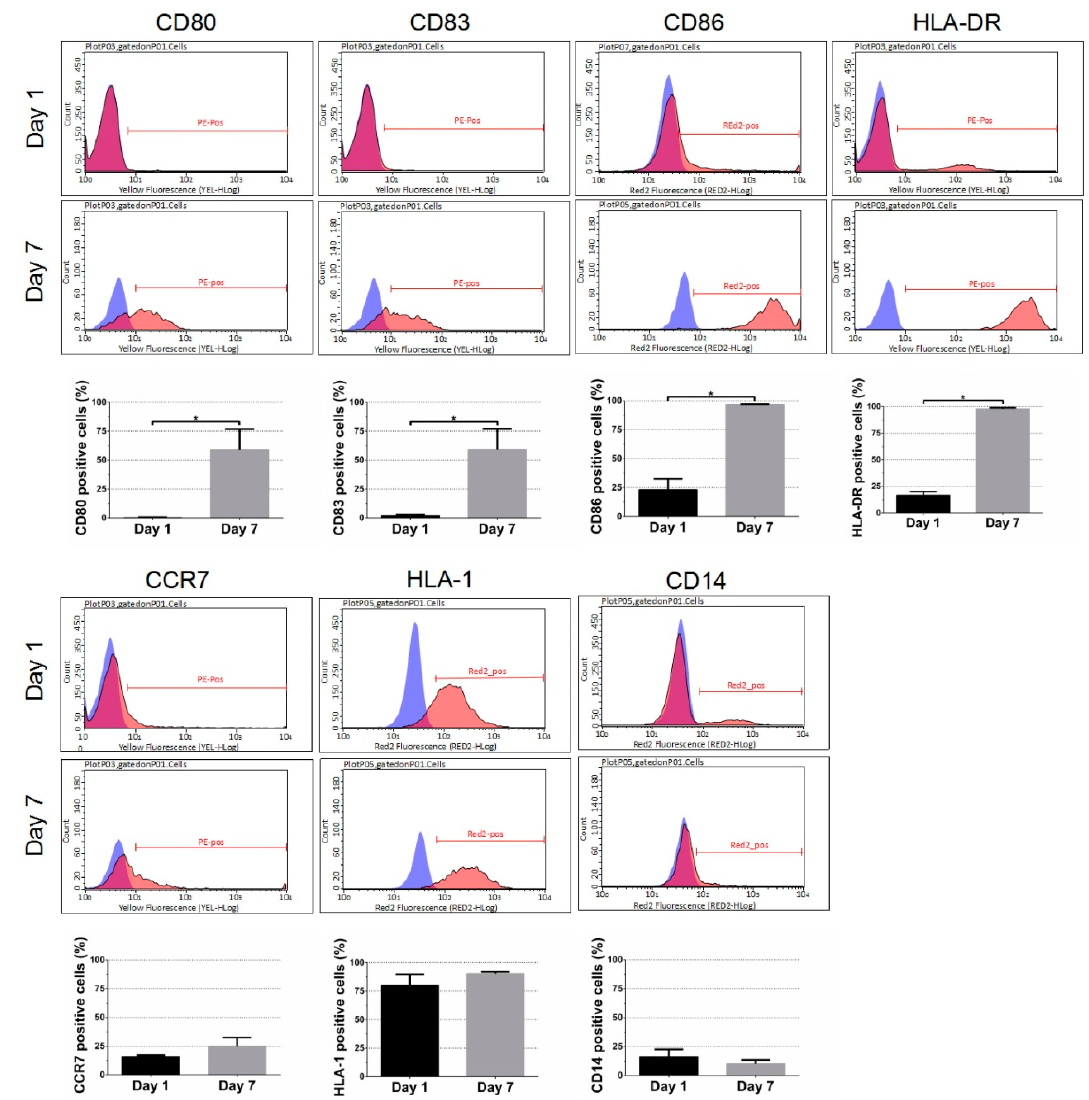
Figure 2. Flow cytometric analysis of cell surface marker expression before (day 1) and after DC differentiation (day 7). Representative flow cytometric histograms are illustrated for dendritic cell marker CD80, CD83, and CD86 expression. Furthermore, HLA-DR, CCR7, and the ubiquitous HLA-1 expression were analyzed. CD14 as a marker for mature monocytes is the only marker showing a decreasing tendency in expression. Results were averaged from 4 independent experiments.